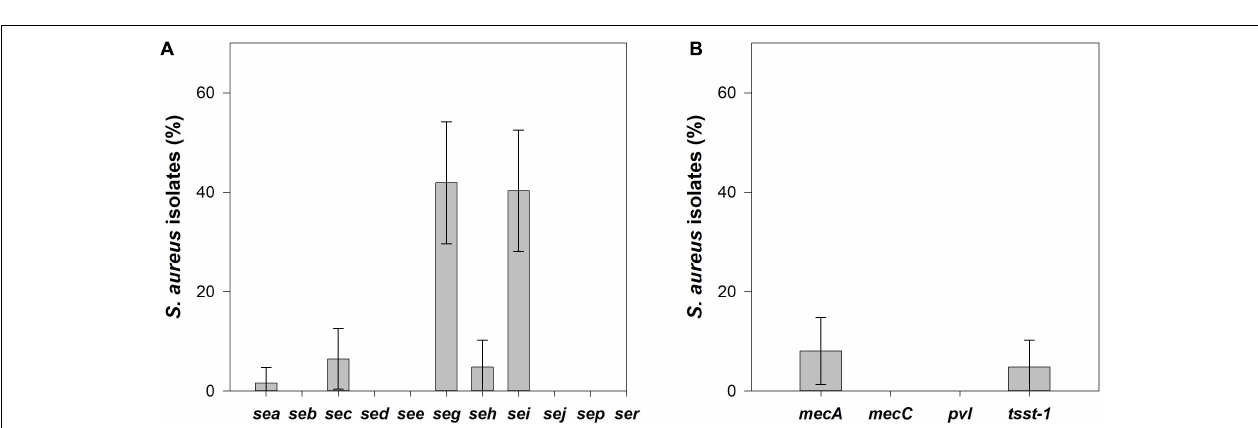
FIGURE 4 | (A) Prevalence and its 95% confidence interval (CI) of enterotoxin coding genes, and (B) methicillin resistance genes, mecA and mecC , toxic shock syndrome toxin-1 ( tsst-1 ) and Panton-Valentine leukocidin ( pvl ) genes in S. aureus isolated from raw cow’s milk samples collected from bulk cooling tanks of 100 dairy farms located in the main dairy basin of mainland